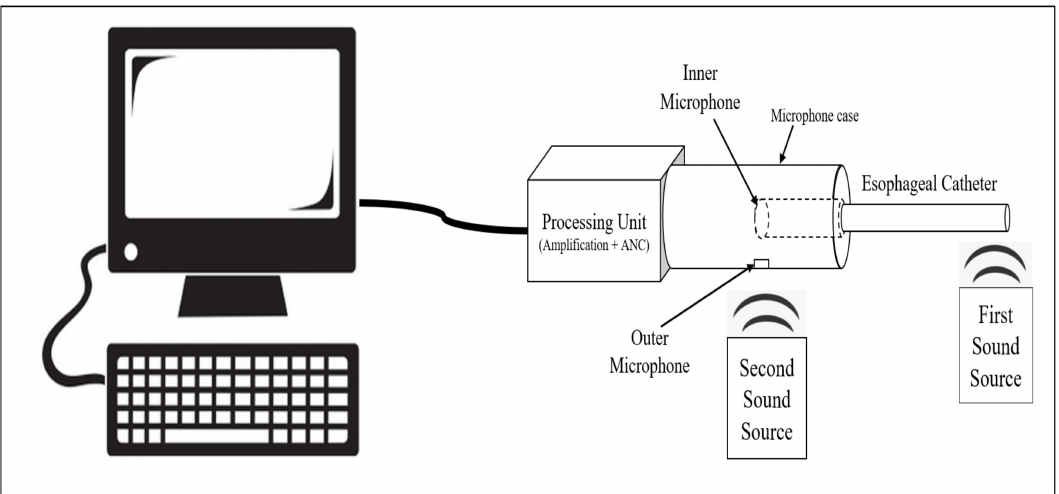
Figure 14. System setup used while collecting and displaying the results.